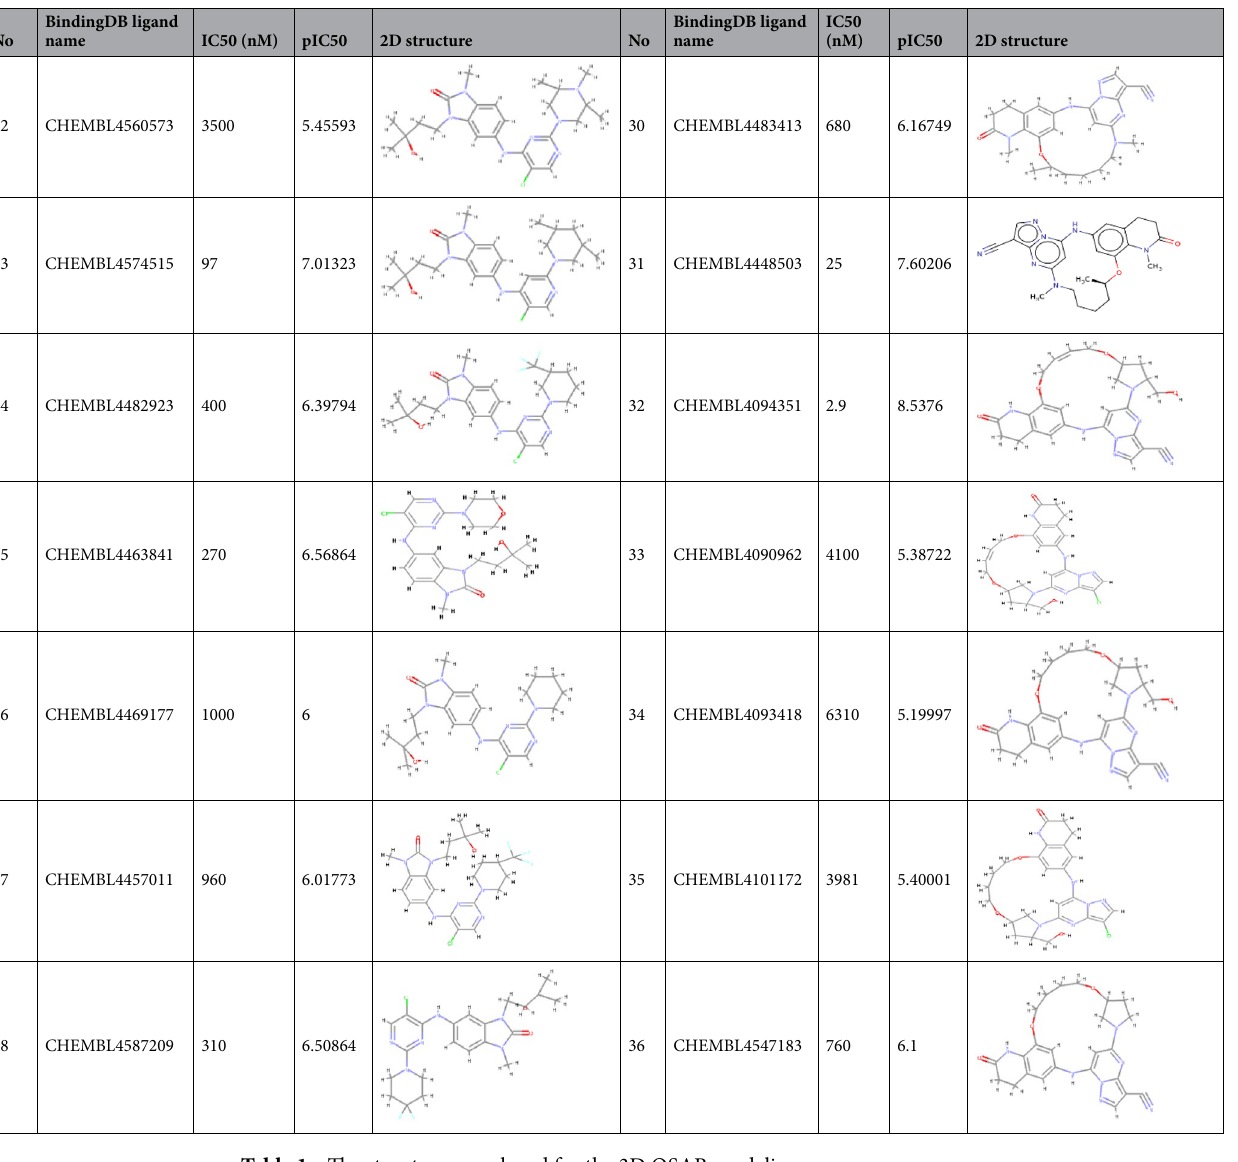
Table 1. The structures employed for the 3D QSAR